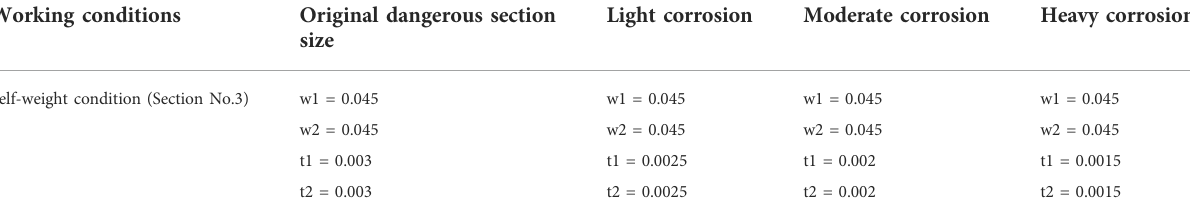
TABLE 2 Cutting thickness of rusted sections under different working conditions.